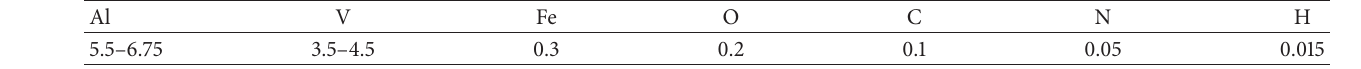
Table 1: Chemical compositions of Ti6Al4V titanium alloy (mass fraction/%).